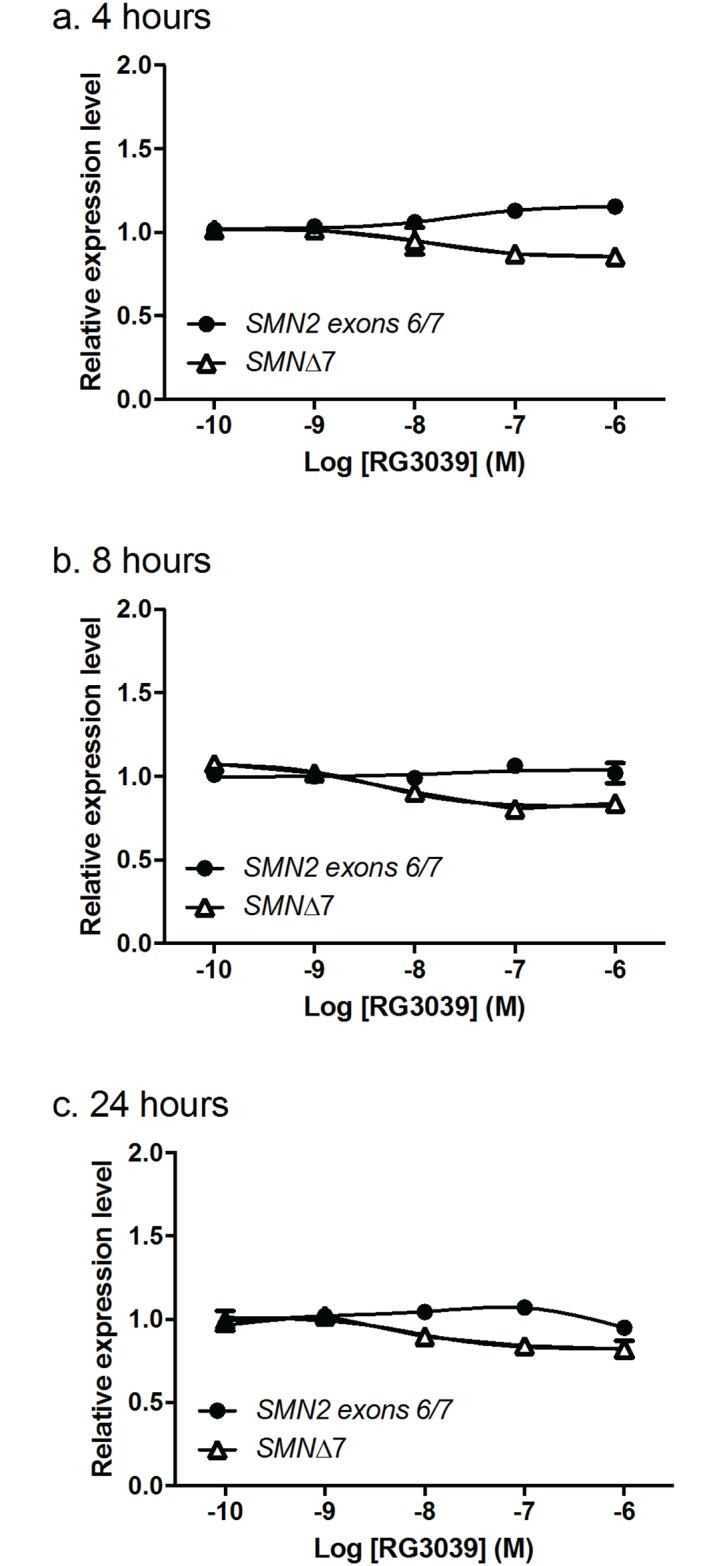
Effect of RG3039 on SMN transcripts.HEK-293T cells were treated with the indicated concentrations of RG3039 for various periods of time (4, 8 or 24hr) before the levels of SMN transcripts were measured using ddPCR. All data shown as mean ± s.e.m. and where not shown error bars are within the size of the symbols.